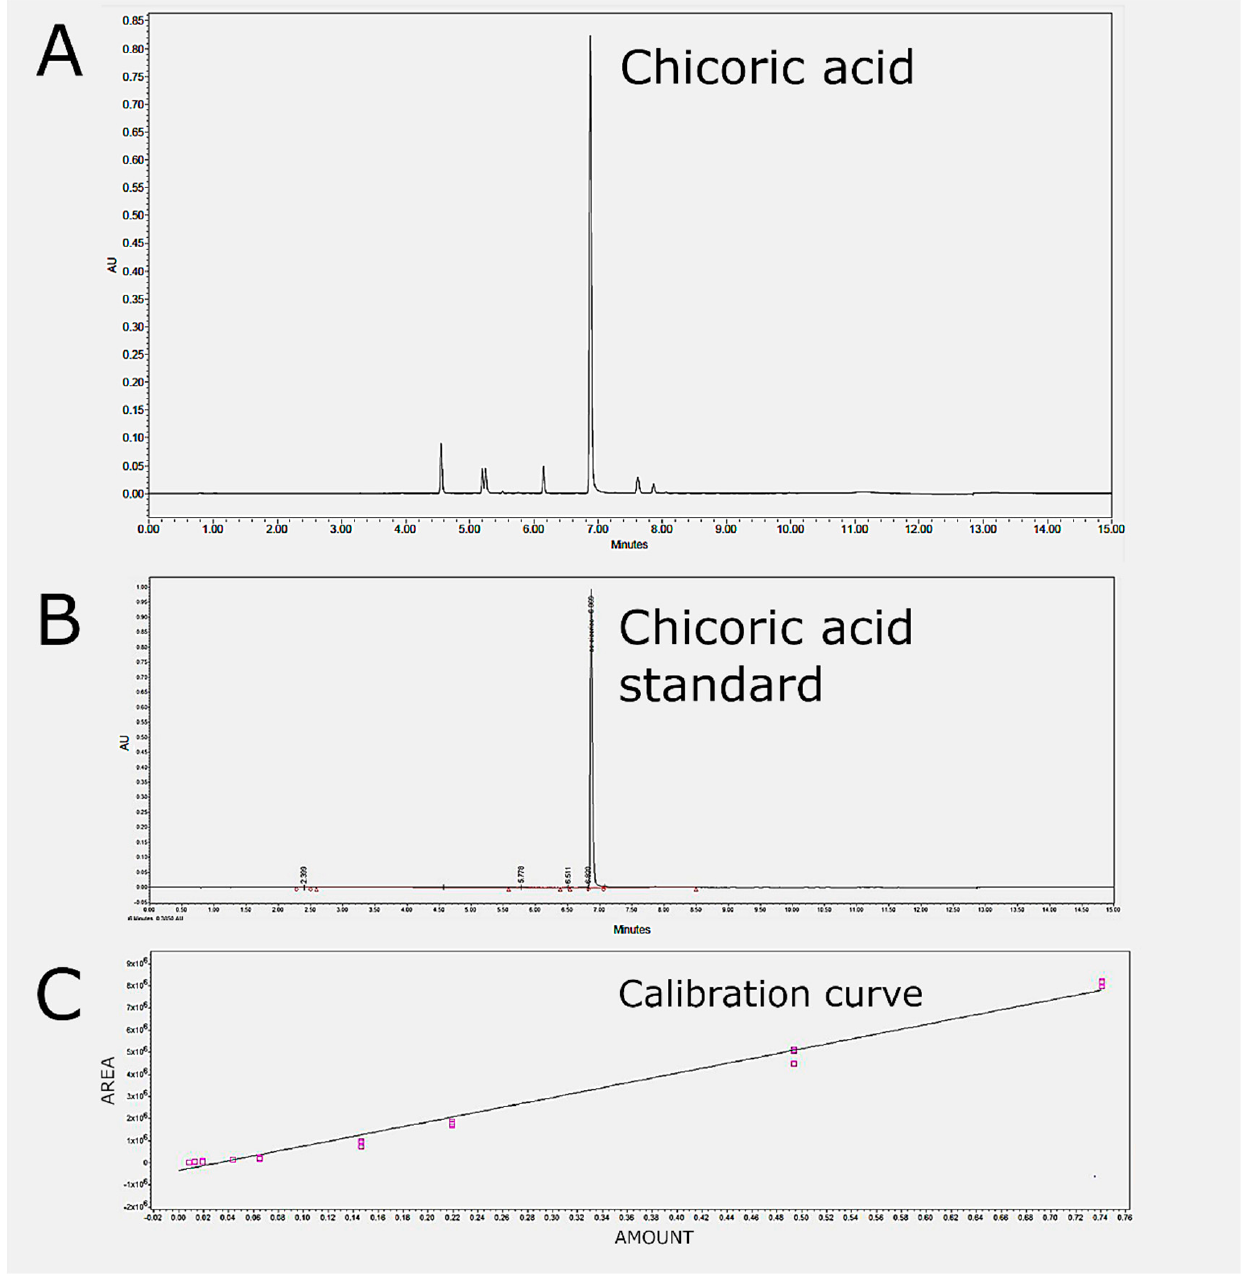
Figure 6. Panel ( A ): Chromatographic profile of the Echinacea purpurea suspension culture extract. The main peak at retention time 6.8 min corresponds to chicoric acid. Panel ( B ): Chromatographic profile of chicoric acid commercial standard. The retention time of chicoric acid peak is at 6.8 min. Panel ( C ): Calibration curve of chicoric acid; values are mean of three independent measures. Calibration curve was obtained by the external standard method, using nine different concentrations (0.148, 0.099, 0.044, 0.029, 0.013, 0.009, 0.004, 0.003 and 0.002 µ g/ µ L)